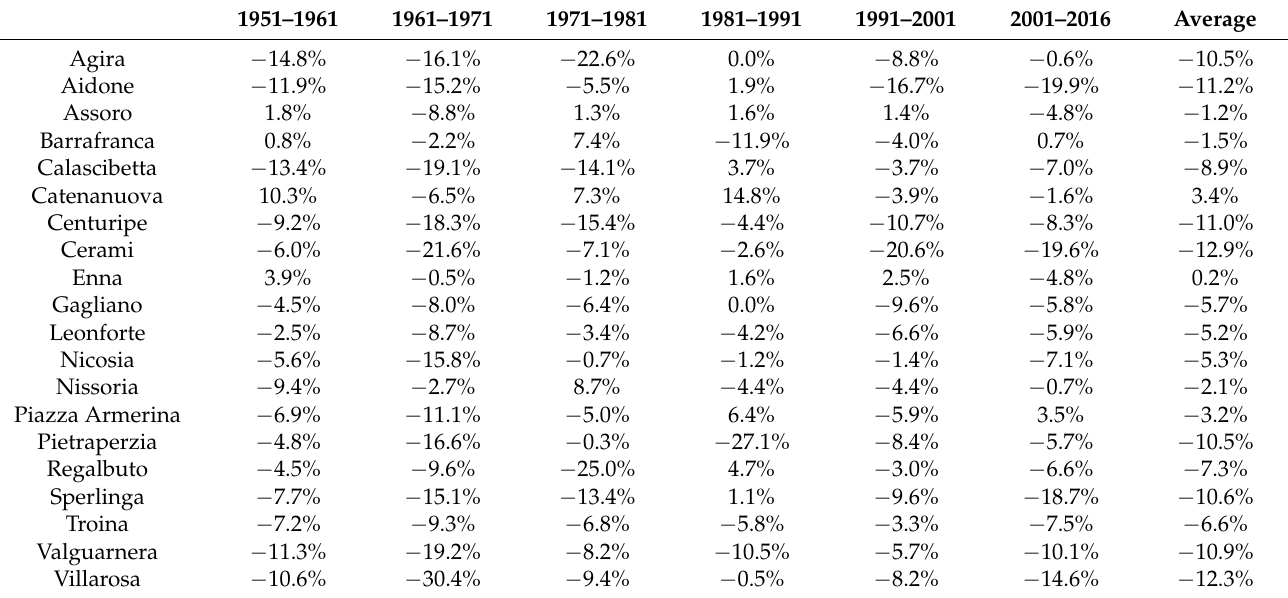
Table 2. 10-Years population variation rates in Enna